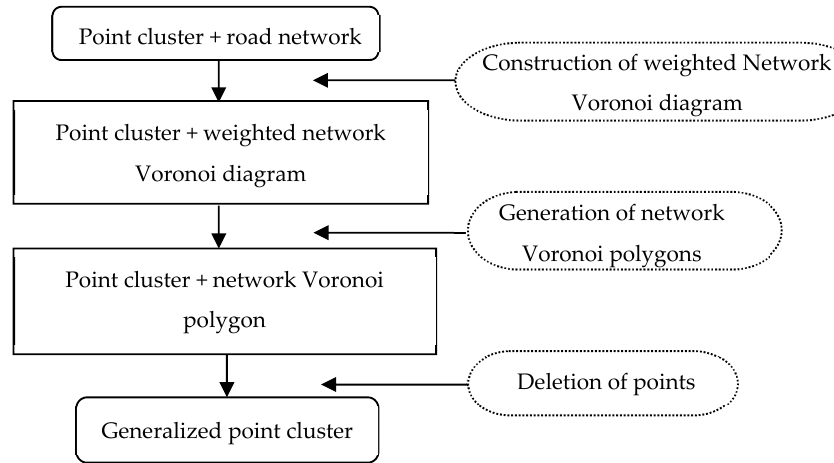
Figure 2. Flowchart of the new